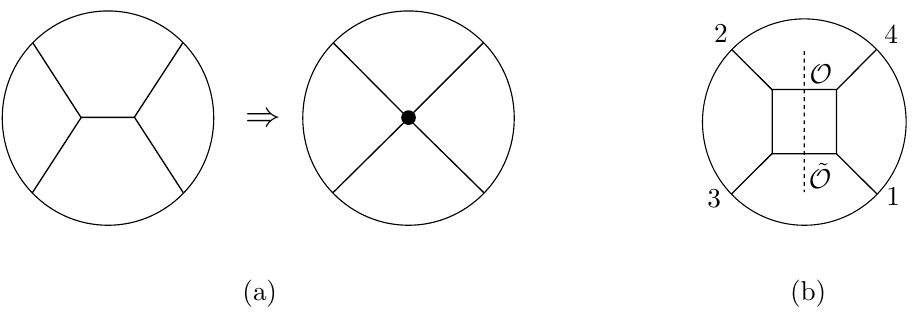
Figure 6 . (a) Integrating out a heavy (cid:12)eld in AdS space produces local higher-derivative interac- tions, suppressed by powers of the heavy mass. (b) The double-discontinuity of a one-loop correction is equal to a product of